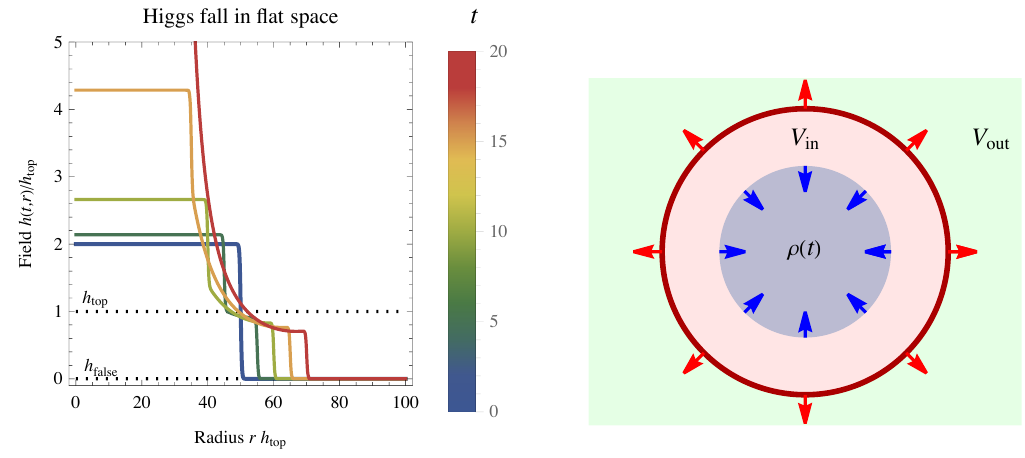
Figure 1 . Left : time evolution in flat space: even assuming an initially thin-wall Higgs profile, its wall expands on both sides, and the thin-wall approximation breaks down. We here assumed the SM Higgs potential of eq. (2.12) and an initial field configuration with ˙ h = 0 and h = 2 h r < 10 /h top and h = 0 outside. The spatial profile of the potential energy V ( h ( t, r )) resembles a sink-hole. Right : the toy model discussed in section 2.2 replaces the thin-wall configuration with rigid interior by an onion-like structure, showing that the collapse of the interior does not imply the collapse of the